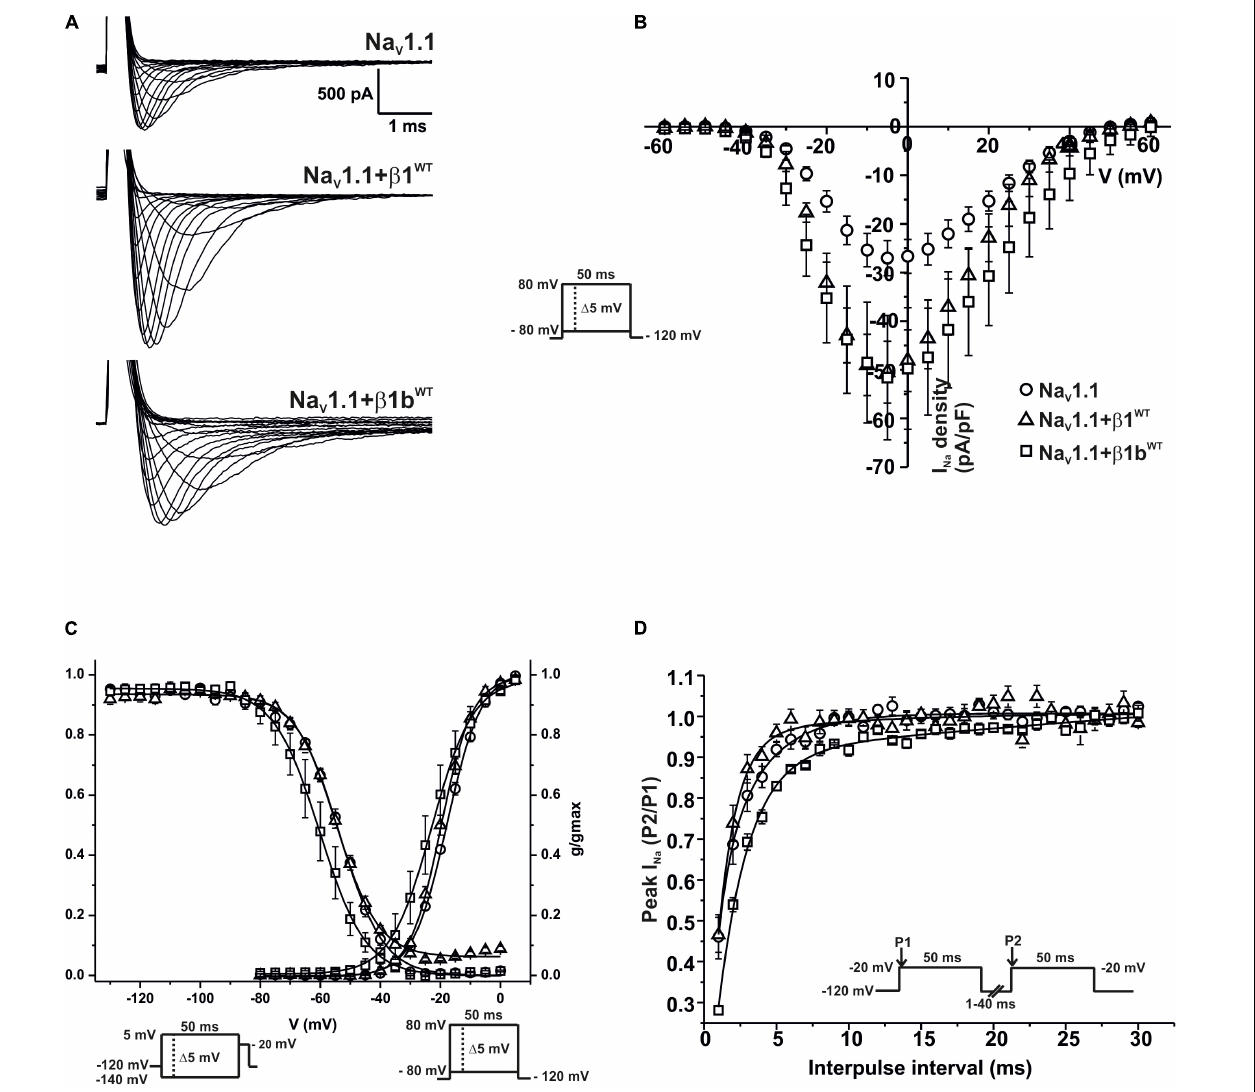
Frontiers in Cell and Developmental Biology |